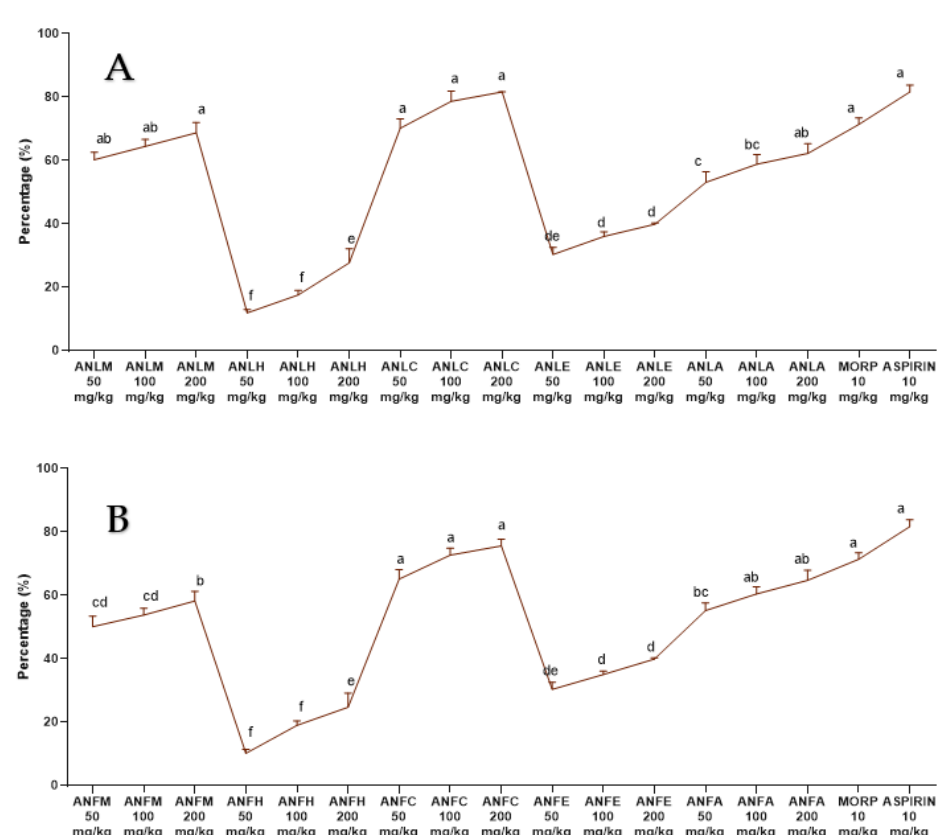
Figure 6. Percentage inhibition of A. nitida on acetic acid induced writhing in rats ( A ) A. nitida leaves methanolic extract (ANLM), A. nitida leaves n-hexane fraction (ANLH), A. nitida leaves chloroform fraction (ANLC), A. nitida leaves ethyl acetate fraction (ANLE), A. nitida leaves aqueous fraction (ANLA) and ( B ) A. nitida fruit methanolic extract (ANFM), A. nitida fruit n-hexane fraction (ANFH), A. nitida fruit chloroform fraction (ANFC), A. nitida fruit ethyl acetate fraction (ANFE), A. nitida fruit aqueous fraction (ANFA). MORP: morphine. Data were analyzed using seven replicates as mean ± SD by one way ANOVA followed by Tukey’s test. Different letters represent the significance level of p < 0.05 with respect to all other samples: “a, b” with reference to positive controls, “c” with reference to methanolic extract and “d, e, f, g” with reference to n-hexane, chloroform, ethyl acetate and aqueous fraction, respectively.